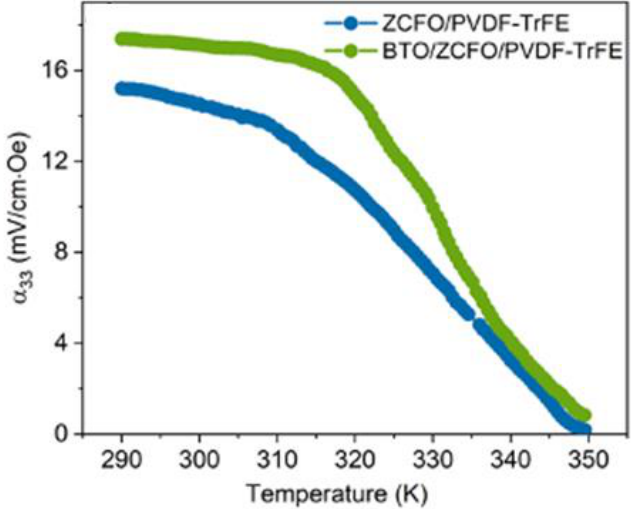
Figure 7. Temperature dependences of ME voltage coefficients ( α ME ) of ZCFO/PVDF-TrFE and BTO/ZCFO/PVDF-TrFE samples for H AC = 3 kOe and f = 10 kHz.